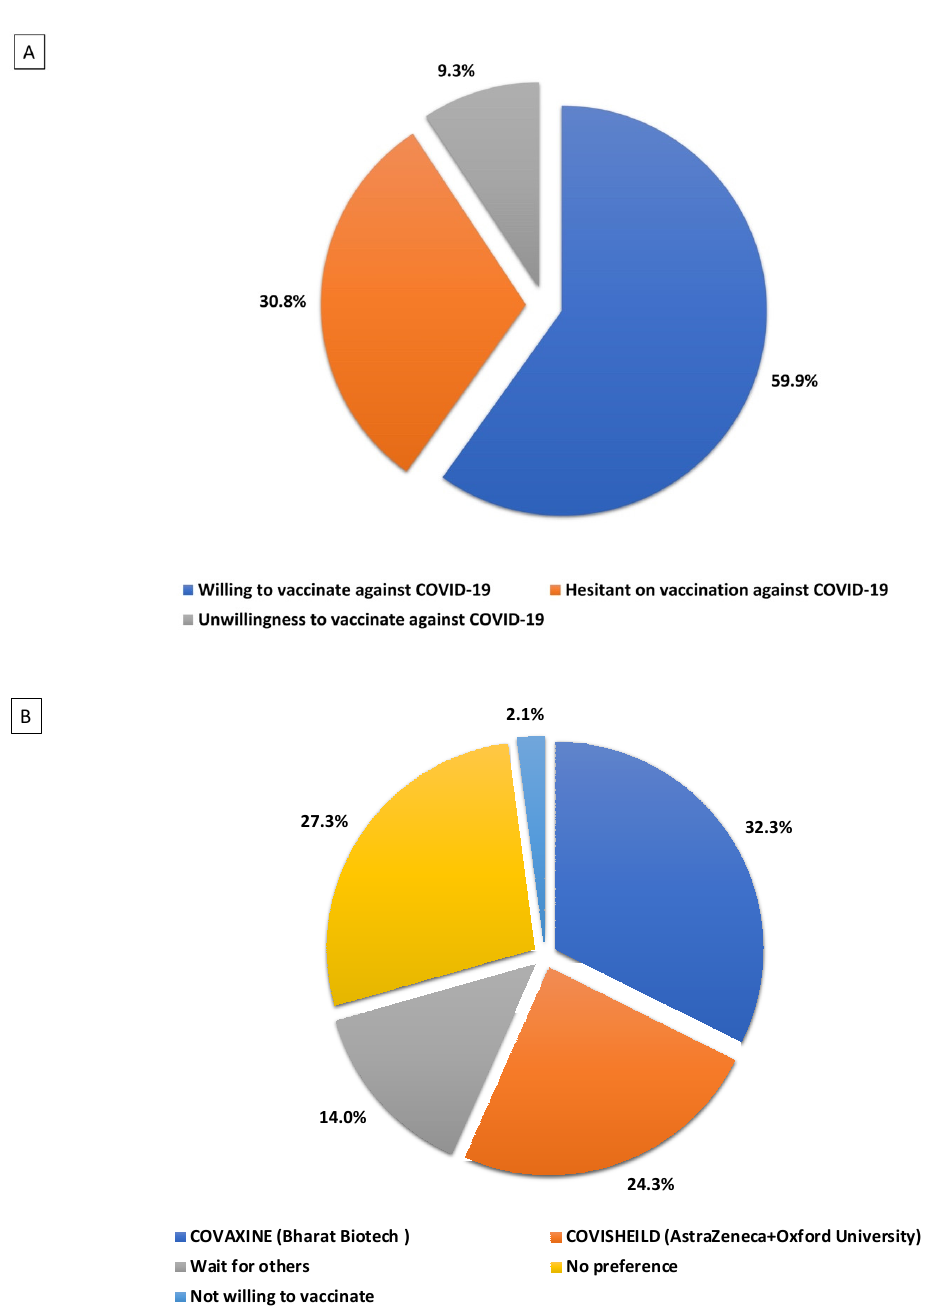
Figure 2. ( A ) Vaccine intentions. The proportion of vaccine intentions measured in the study population of n = 1582. Almost 60% were willing to vaccinate, 30% were hesitant about vaccination, and 10% were unwilling to vaccinate. ( B ) Type of vaccine preferred in the study population. The type of vaccine against COVID-19 preferred in the study population of n = 1582. The majority of the population preferred either COVAXINE (32.3%) or COVISHEILD (24.3%).